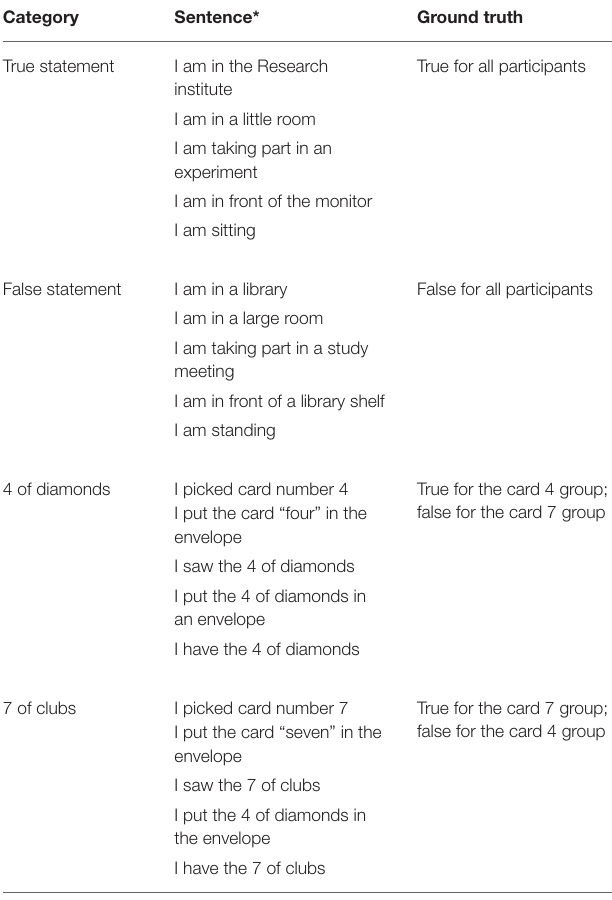
TABLE 1 | Sentences used in the autobiographical implicit association